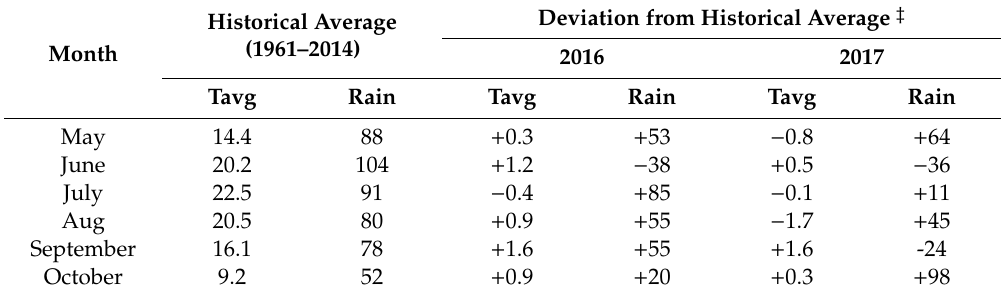
Table 2. Comparison of 2016 and 2017 monthly average air temperature (Tavg; ◦ C) and total rainfall (Rain; mm) with historical averages at Lamberton, Minnesota, the United